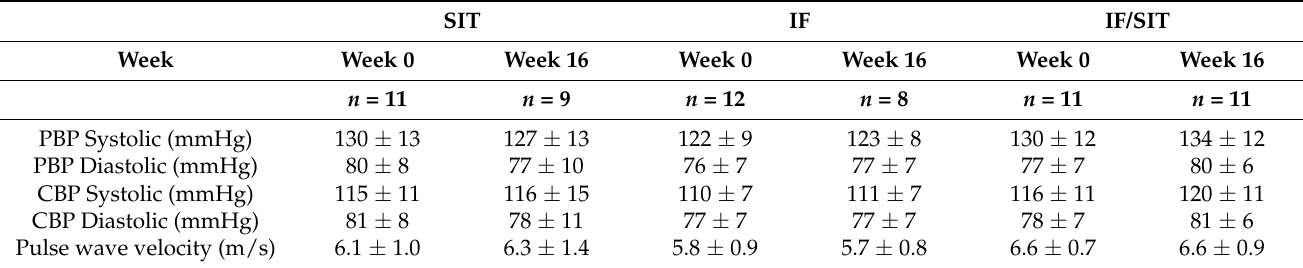
Figure 3. The effect of diet and/or exercise intervention on VO2 peak . Values are mean ± SD ** denotes a significant difference between the IF and IF/SIT groups ( p < 0.01). Abbreviations: SIT: sprint inter- Table 3. The effect of diet and/or exercise intervention on peripheral and central blood pressure and pulse wave